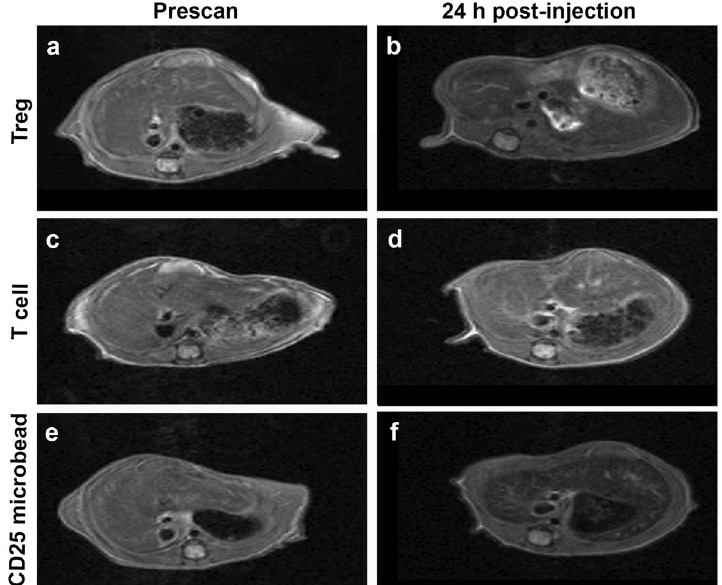
Figure 7. Axial T2-weighted liver MR images of mice pre and 24 h post-intravenous injection of labeled cells or CD25 microbeads. Representative images of CD25 microbead-labeled Treg receiving mouse pre ( a ) and 24 h-post ( b ) IV injection show T2 signal reduction compared to CD25 microbead-labeled T cells ( c and d , negative control). Positive control mice receiving CD25 microbeads alone intravenously show marked T2 signal decrease 24 h post-injection ( e,f ).